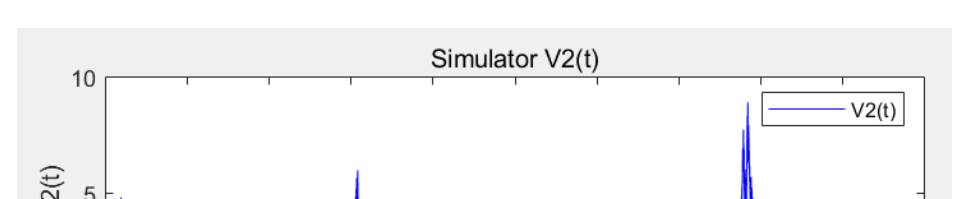
Figure 2. Sample path of V1(t).